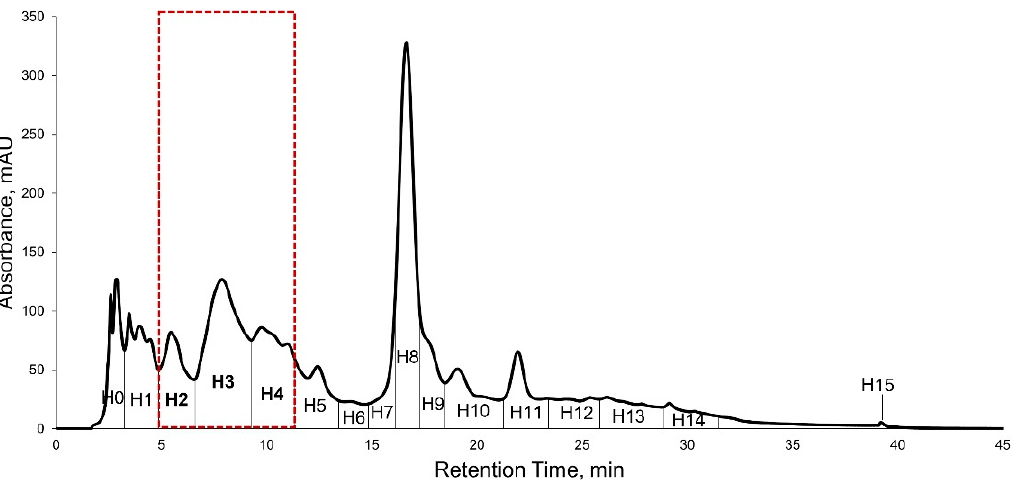
Figure 5. HPLC Chromatogram of KADAMEI3I7 (UV λ max 254 nm, black curve line). HPLC Fractions H2, H3, and H4 (highlighted broken line) showed antibacterial activity against MDRSA. The sixteen HPLC fractions obtained were tested at 64 μ g/mL against MDRSA. The sample treated wells were compared with tetracycline (32 μ g/mL) and vancomycin (2 μ g/mL) as the positive control, and DMSO as the negative control. Three HPLC fractions exhibited complete growth inhibition (>90%) against MDRSA namely: (1) KA ‐ DAMEI3I7H2, H3, and H4 (Figure 6), which corresponds to HPLC peaks highlighted in Figure 5. Fractions KADAMEI3I7H2, KADAMEI3I7H3, and KADAMEI3I7H4 exhibited complete growth inhibition after 24 h at minimum inhibitory concentration of 32 μ g/mL